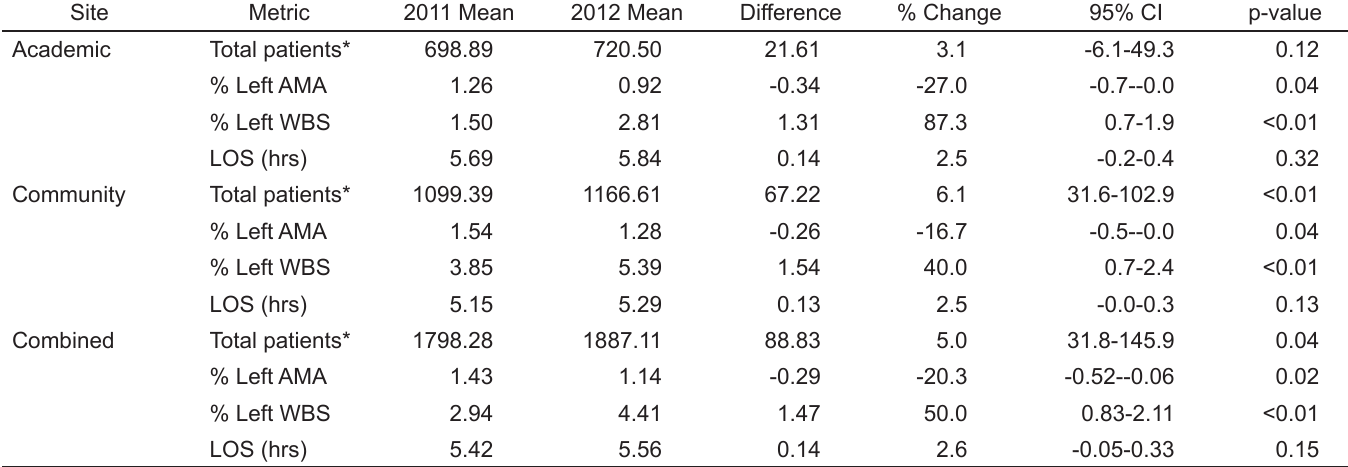
Table 2. Pre-post differences in emergency department flow metrics at each site and for the combined sample.